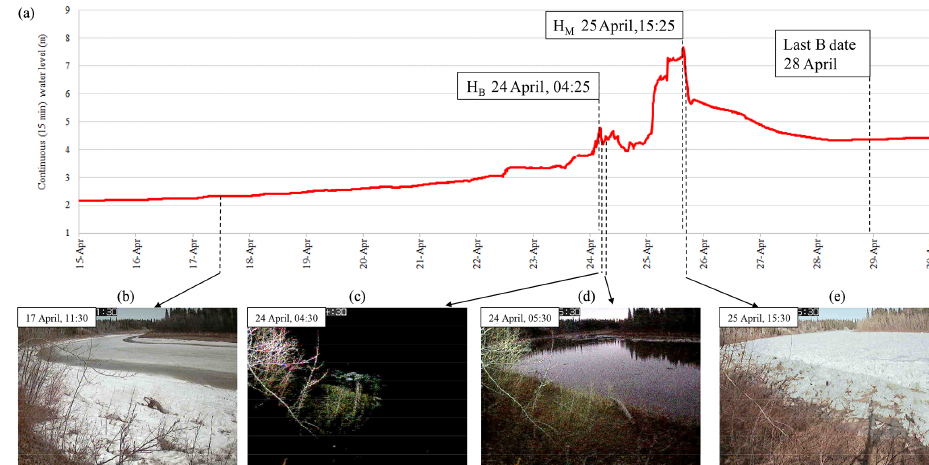
Figure 12. Continuous 15min interval water level hydrograph for 15 to 30 April 2010 at the National Hydrometric Program Hay River gauging station near Hay River (07OB001), along with images courtesy of the Alberta Research Group. (b) Image looking upstream taken 7d prior to spring break-up initiation (H B ) of 24 April 2010, 04:25UTC. Channel width of approximately 63m. Panel (c) is a night-time image 5min after H B and shows evidence of fragmented ice in the channel. Panel (d) was taken 65min after H B and shows the channel nearly clear of ice. Panel (e) was taken 5min after the maximum spring break-up water level on 25 April 2010, 15:25UTC. Stranded ice on channel banks indicates higher water levels. The last B date was 28 April